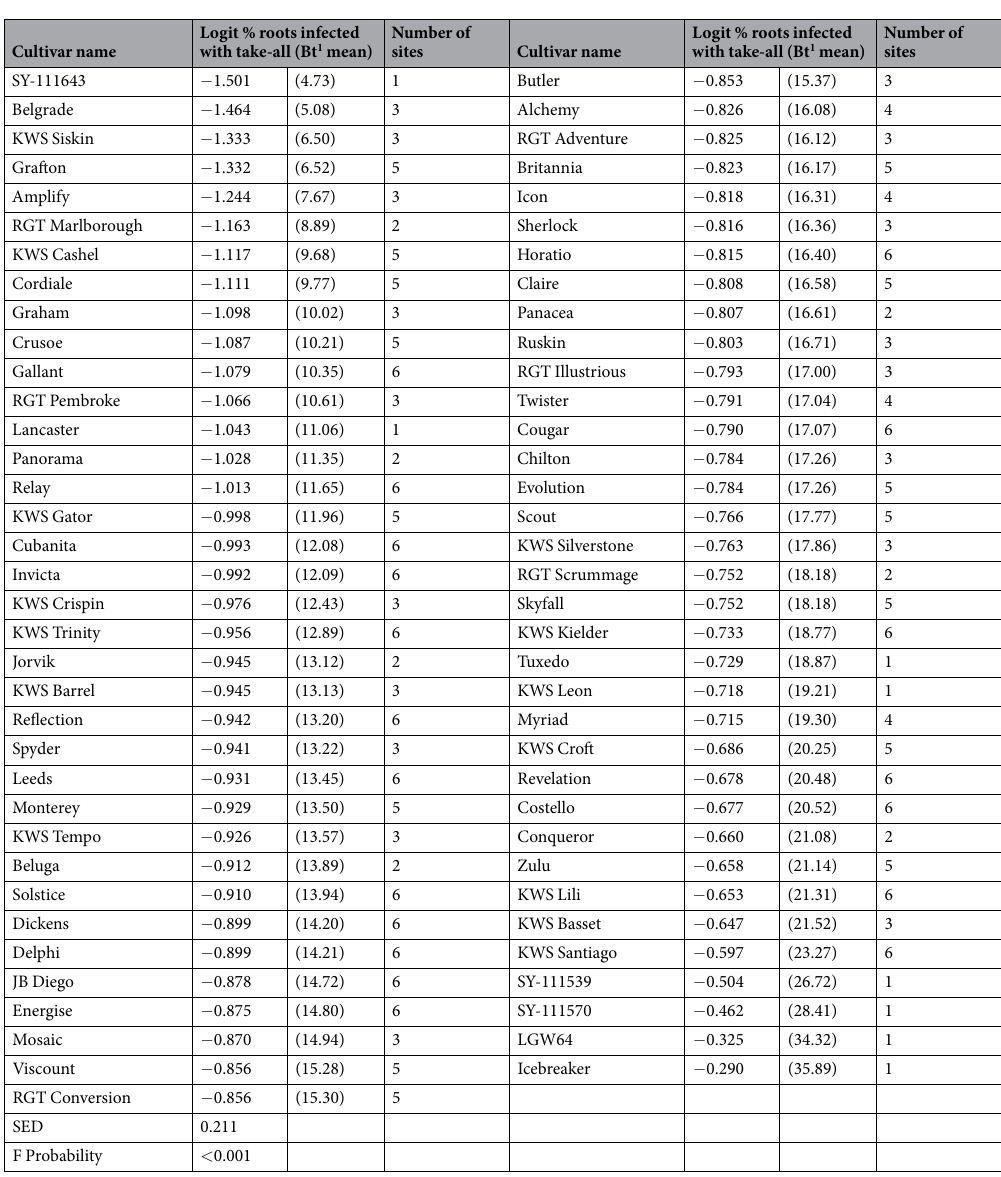
Table 2. Pooled TAB phenotyping analysis of the percentage roots infected with take-all at the six sampled AHDB experimental sites in 2013/14 and 2014/15. 1 Bt =